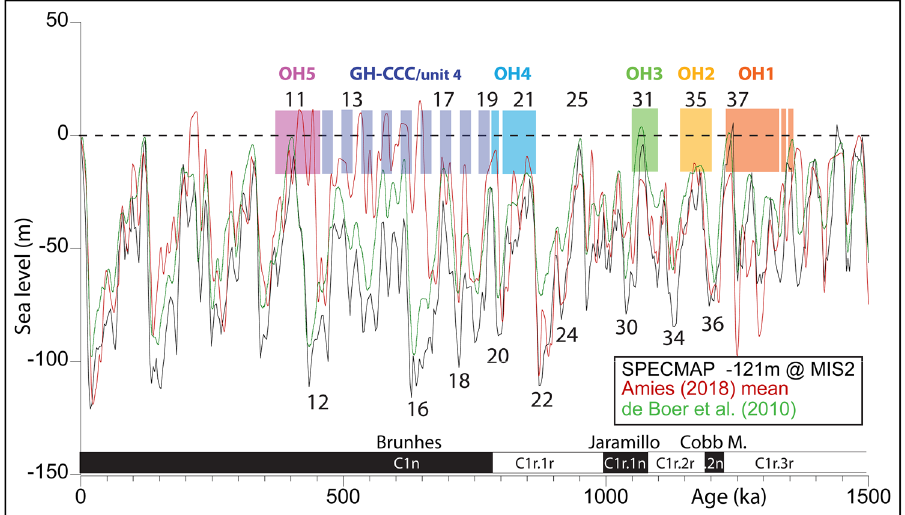
Figure 6. Various glacioeustatic solutions for the past 1.5 Myr as revealed from the ODP677/SPECMAP benthic δ 18 O record 24 scaled to the 121 m glacioeustatic lowering at the last glacial maximum 25 , the solution of Rohling et al. 26 based on Amies (2018) SST-corrected 27 Mediterranean planktic δ 18 O data [solution termed ‘Amies (2018) mean’ in figure], and the solution of de Boer et al. 28 based on the benthic δ 18 O stack of Lisiecki and Raymo 23 . Main marine isotope stages (MISs) are indicated by standard numbering whereby odd-numbered stages represent interglacials and even-numbered stages glacials. The geomagnetic polarity time scale of the Pleistocene is also reported together with the inferred ages of deposition of the studied units from OH5 to OH1. Drawing G. Muttoni. This figure was created with Adobe Illustrator CS6 version (http:// www. adobe.